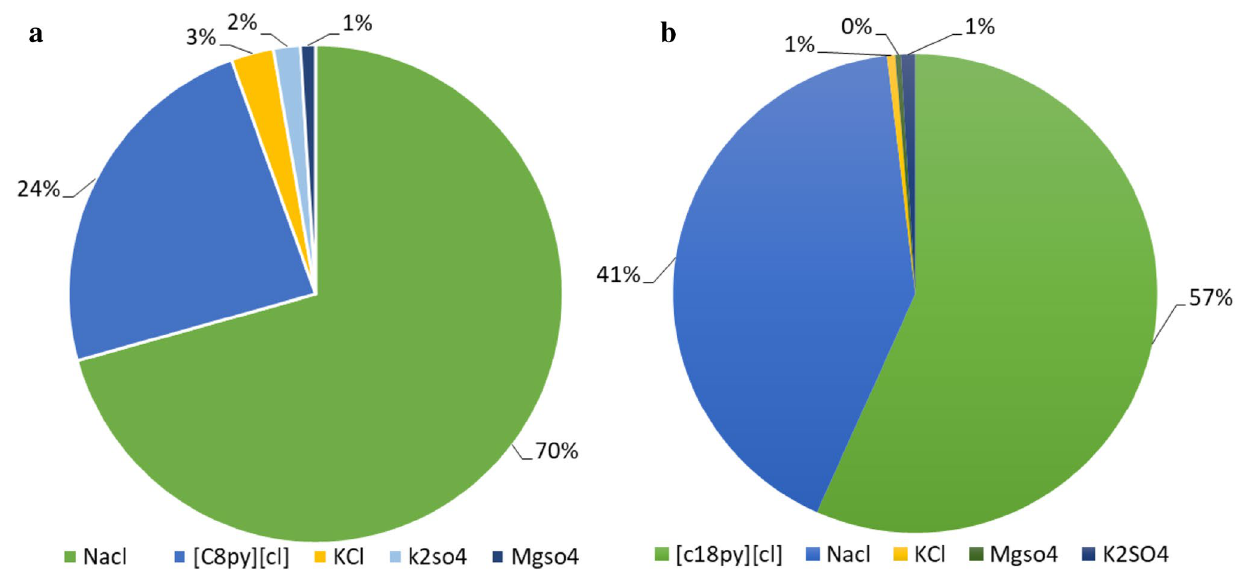
Fig. 4 Statical analysis on IFT values a [C 8 Py][Cl] with the presence of KCl, K 2 SO 4 , MgSO 4 and NaCl at different concentration levels, and b [C 18 Py][Cl] with the presence of KCl, K 2 SO 4 , MgSO 4 and NaCl at different concentration